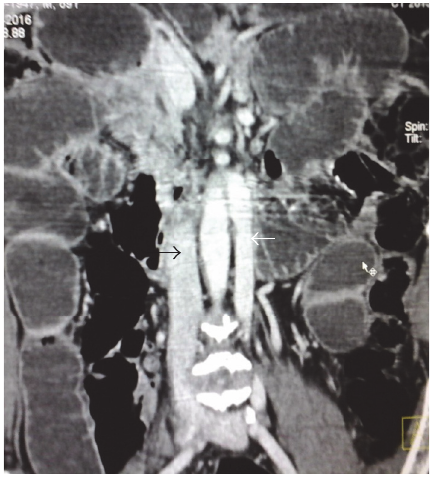
Figure 3: Coronal CT image showing double IVC with small left IVC (white arrow) and large caliber right IVC (black